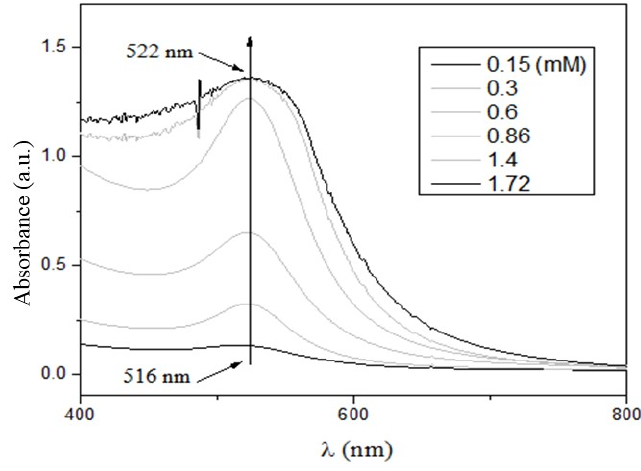
Figure 2. UV-vis spectrum of the liquid samples of gold nanoparticles synthesized with different concentrations.